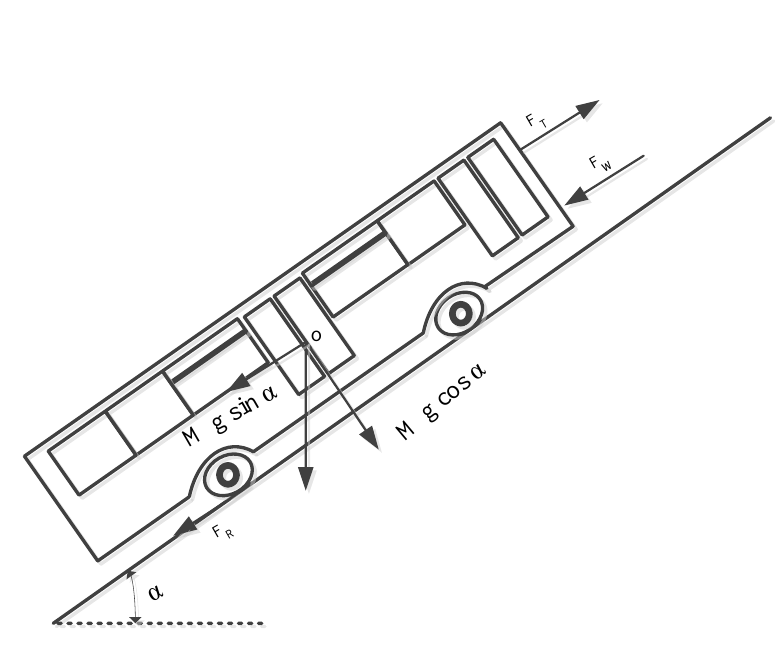
Figure 1. EB moving uphill and forces opposing the movement.